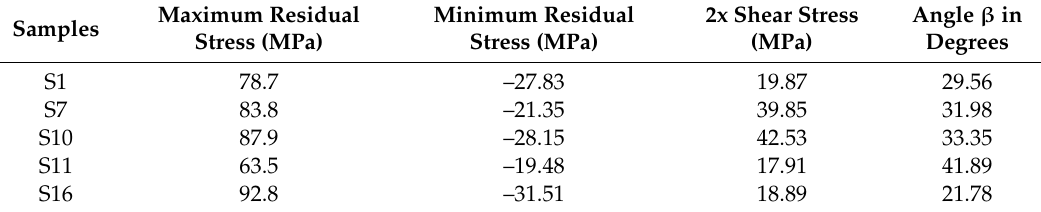
Figure 6. Strain gauge rosette locations for residual stress measurements. Table 12. Residual, shear stresses and angles for TBW Samples.